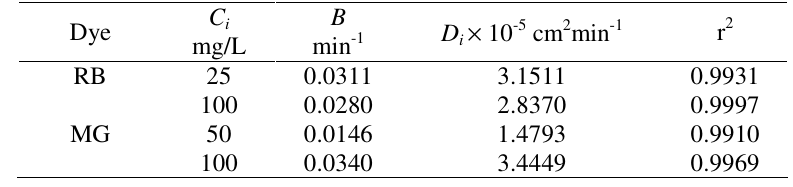
Table 6 . Isotherm constants for adsorption of Dyes at 45 ° C Dye